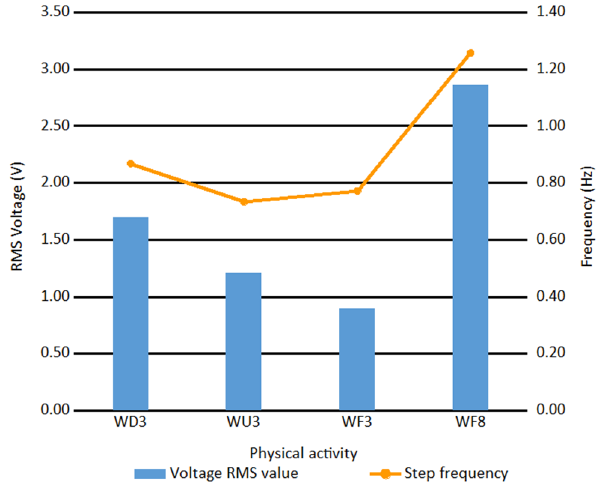
Figure 16. Generator output parameters for different physical activity types.